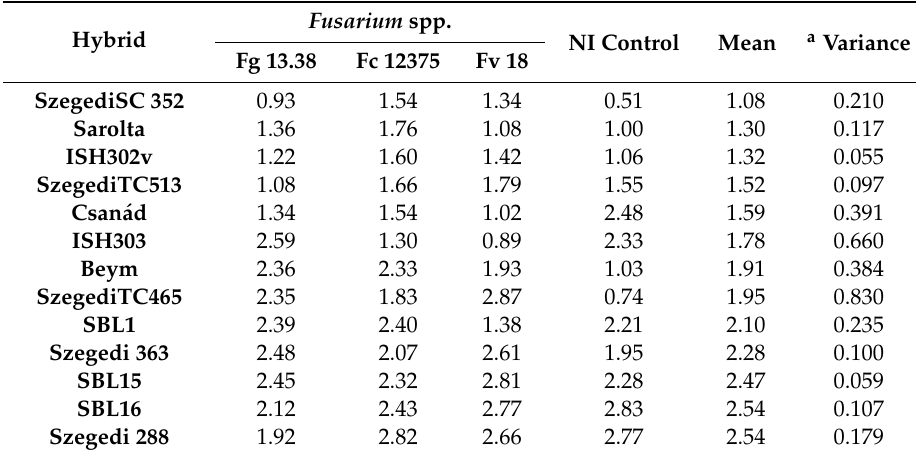
Table 5. Resistance of maize hybrids to toxigenic fungi. Silk channel method, ear coverage as percentage, ( n = 44) Szeged,